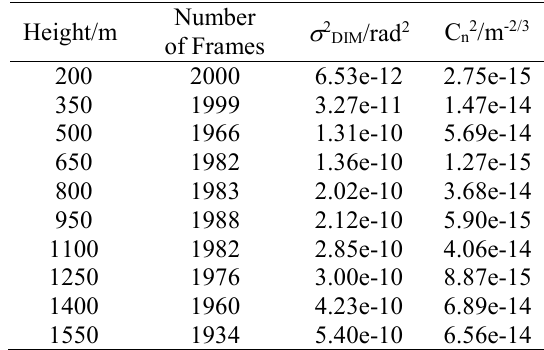
Table 1 Data of Remote Sensing and Turbulence Profile